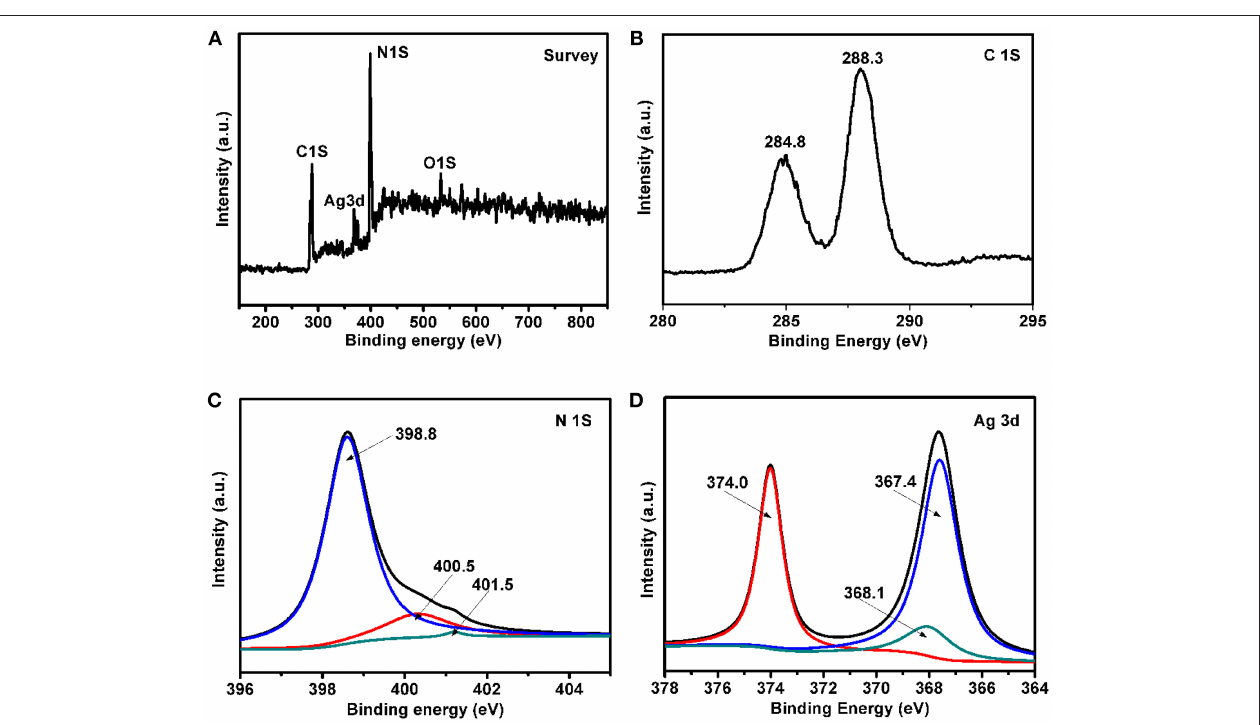
FIGURE 4 | XPS spectra of 3%-Ag/g-C 3 N 4 composites: (A) survey XPS spectrum, high resolution of (B) C1s spectra, (C) N1s spectrum, (D) Ag 3d spectrum.